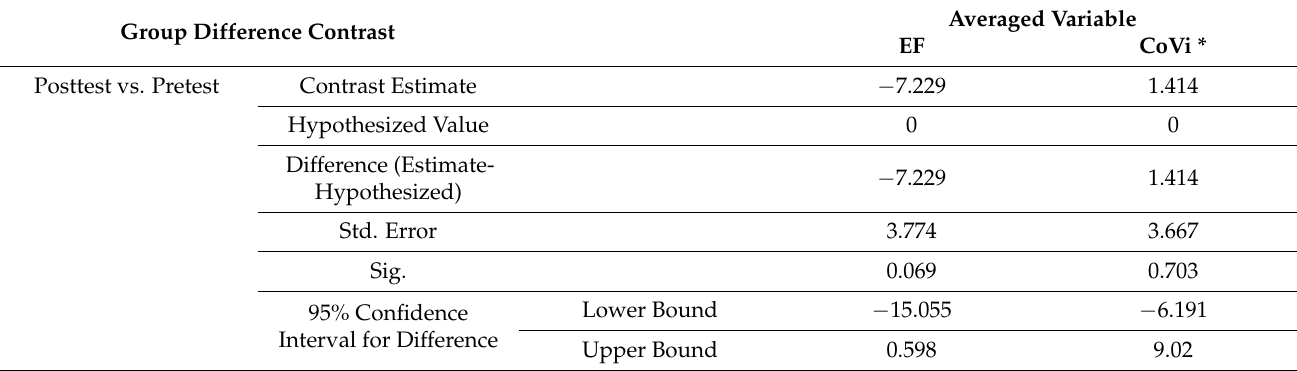
Table 4. Contrast Results (K Matrix).